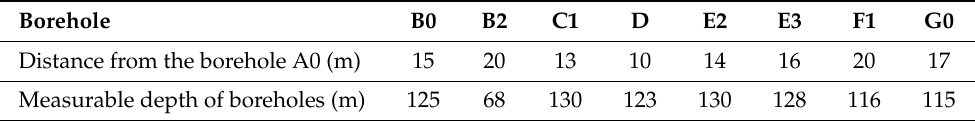
Table 2. Basic information about monitoring boreholes of Small Research Polygon .